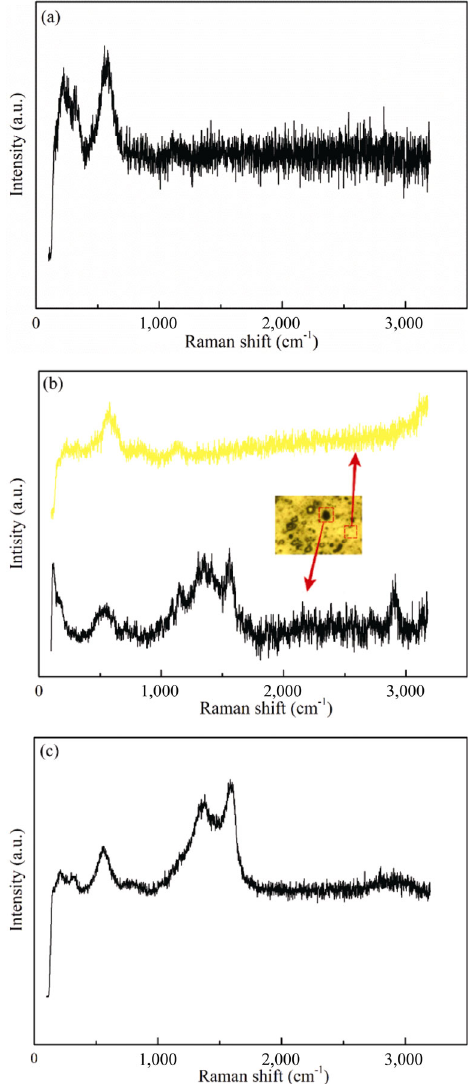
Fig. 9 Raman spectrum of wear scar of (a) TiN–Ag of 2 at% Ag, (b) TiN–Ag of 10 at% Ag, and (c) TiN–Ag of 30 at% Ag (voltage: 1.5 V; load: 15